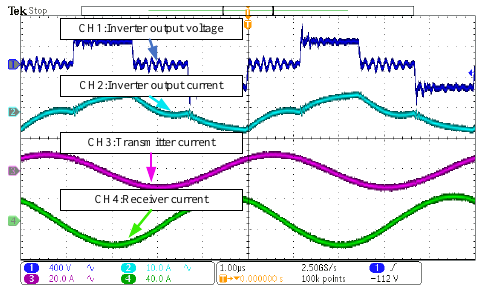
Figure 22. Working waveforms with UAV and nanocrystalline.